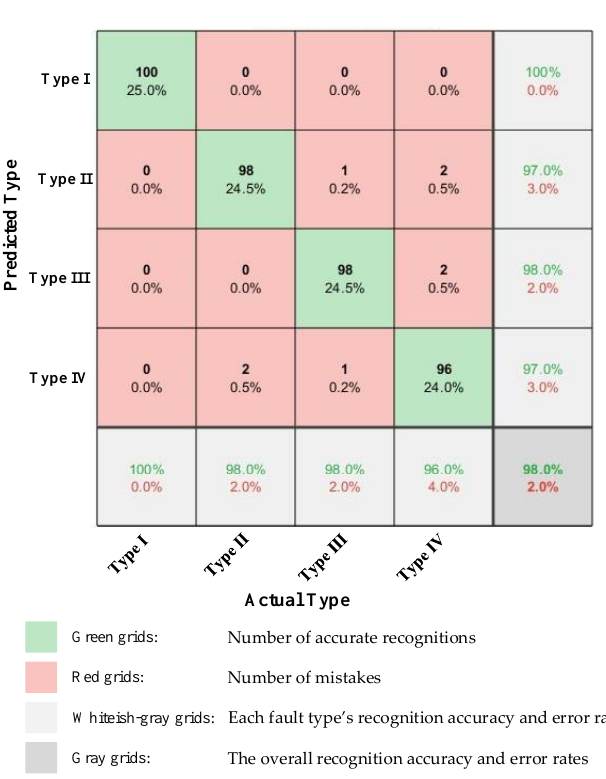
Figure 13. Confusion matrix of CNN for fault diagnosis of power cable.